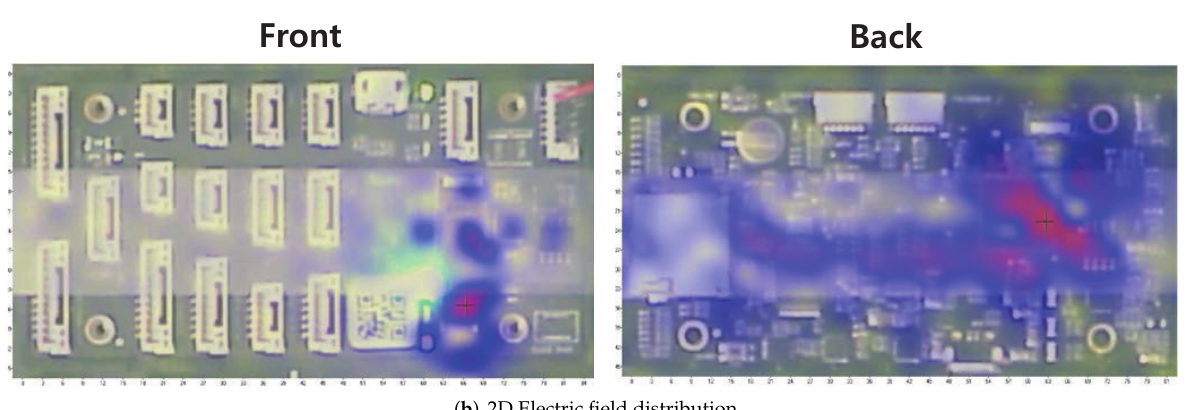
Figure 5. Result of flight controller near-field scanning. Both the front and back sides were scanned, and the probe tip is effective from 30 MHz to 3 GHz. ( a ) Near-field scanning results showing peak value of each frequency. ( b ) 2D electric-field distribution at the frequency with the highest peak value for each aspect. (Front: 143.2 MHz, Back: 256 MHz).